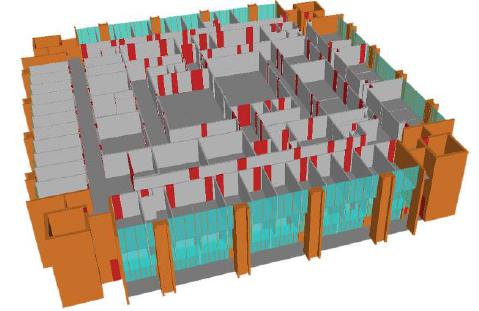
Figure 3. An example of reconstructed integrated 3D building